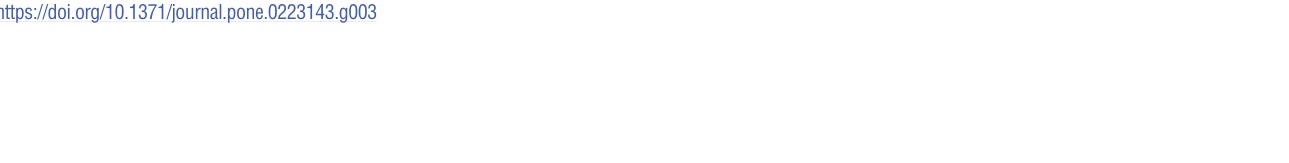
PLOS ONE | https://doi.org/10.1371/journal.pone.0223143 September 30,